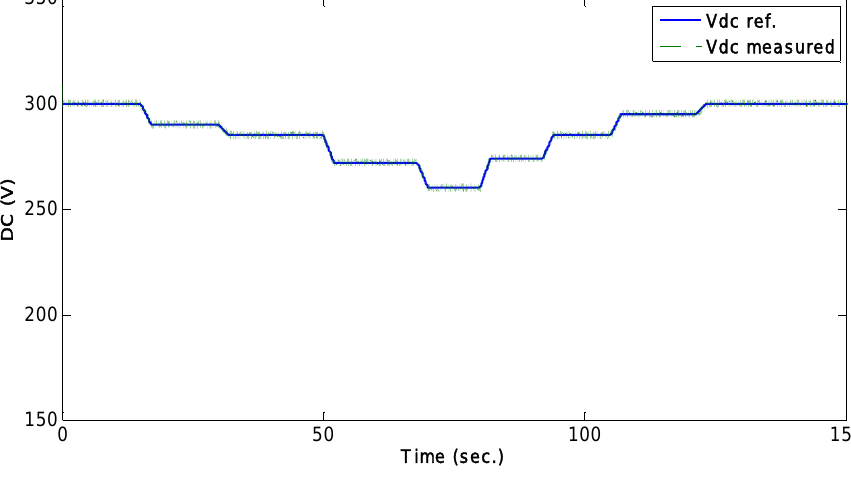
Figure 13. Response of the DC-link voltage